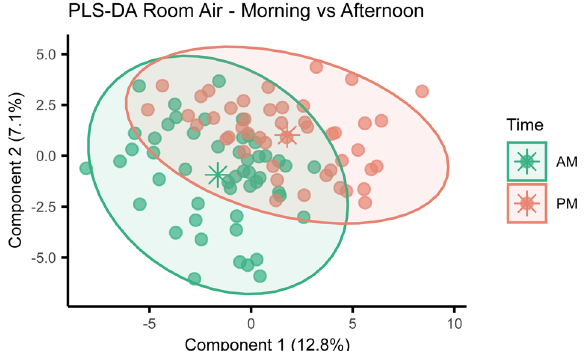
Figure 2. Room air VOC profiles change during the day. Supervised analysis with PLS-DA showed separation between room air samples collected during the morning or during the afternoon (R 2 Y = 0.46, Q 2 Y = 0.22, p < 0.001). Ellipses show 95% confidence intervals and asterisks group centroids.